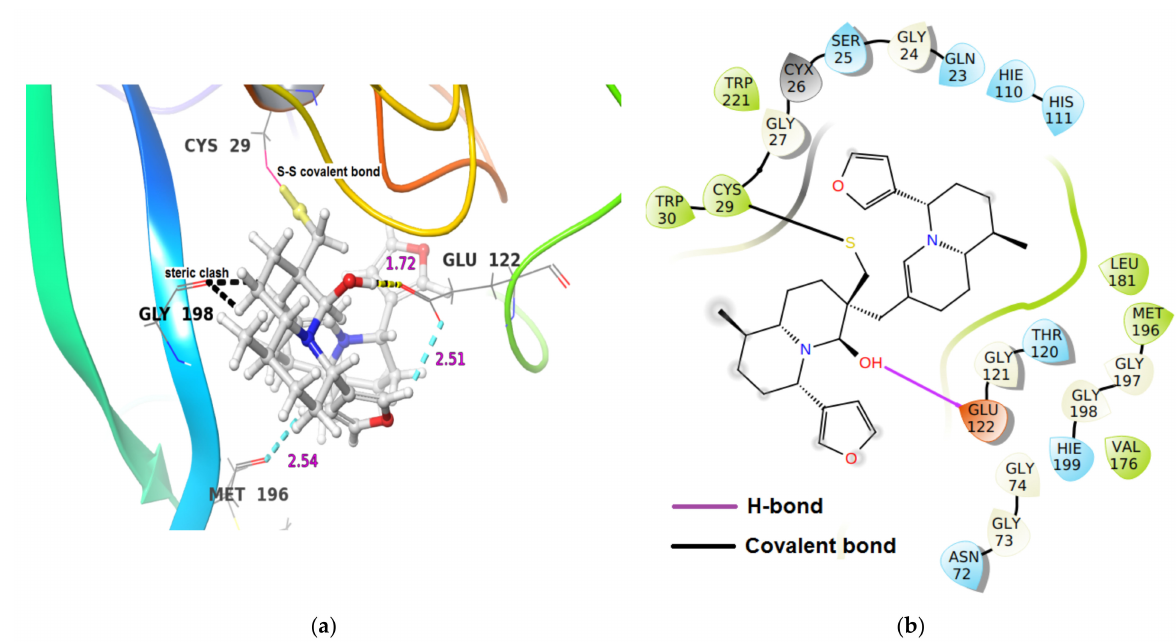
Figure 7. ( a ) 3-D representation of intermediate DTBN(iDTBN) docked to Cathepsin B. H-bond interaction is displayed by yellow dotted lines, C-H ... O hydrogen bonds are displayed by cyan blue dotted lines, steric clashes are displayed by black dotted line, ( b ) 2-D Ligand interaction diagram of iDTBN docked to Cathepsin B.